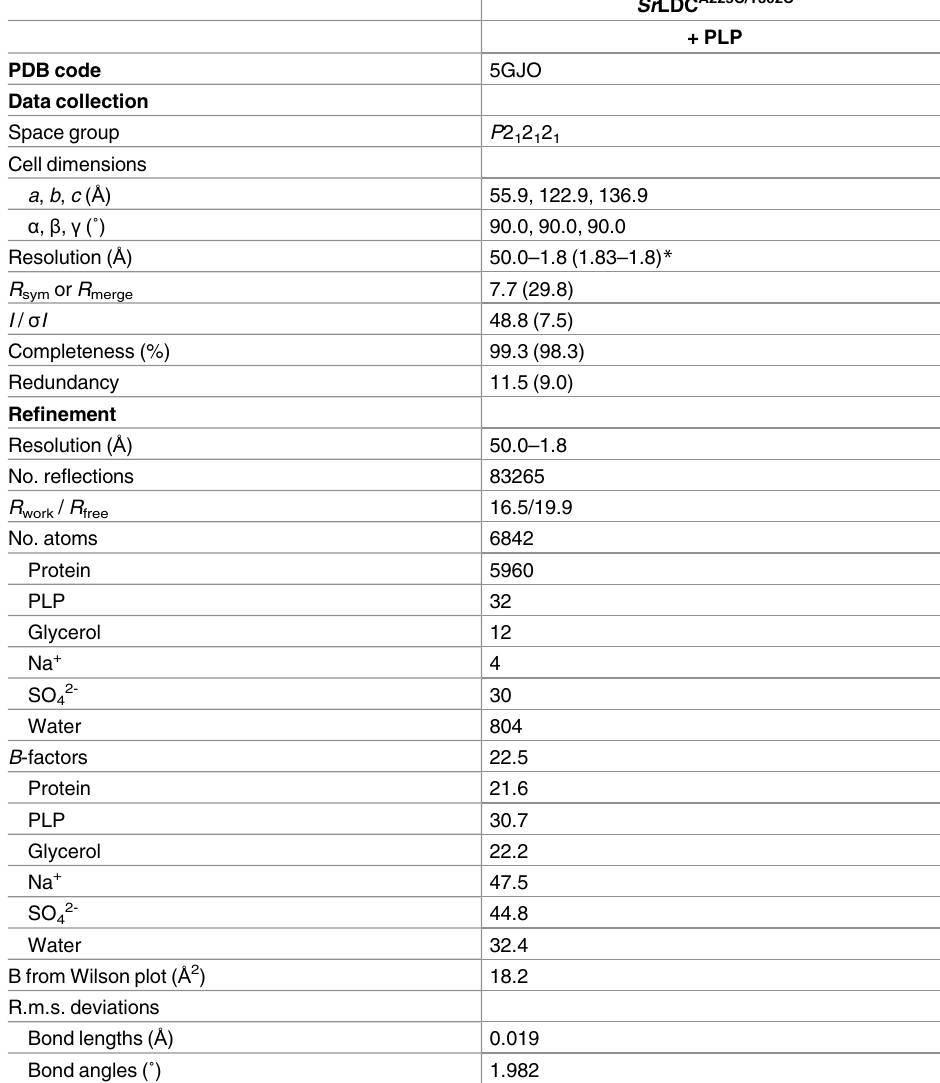
Table 1. Data collection and refinement statistics of Sr LDC A225C/T302C